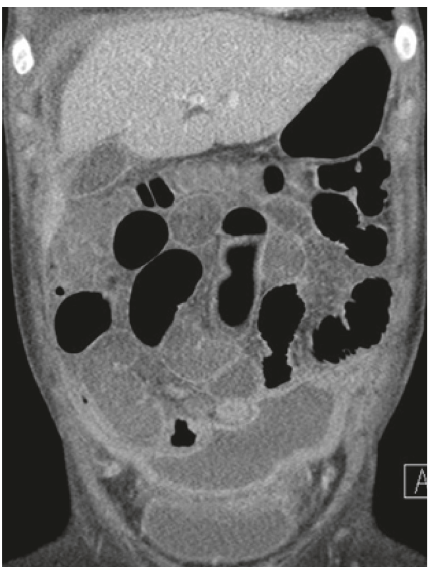
Figure 3: CT scan nine days after surgery with persistent ascites and peritoneal